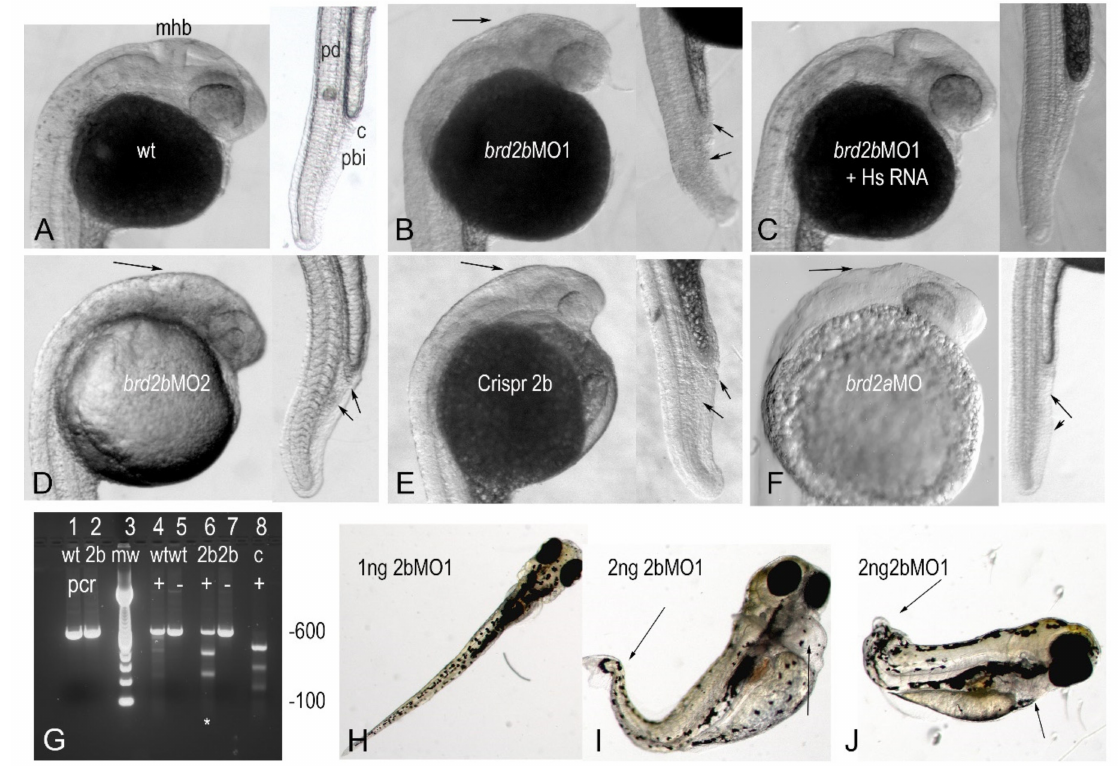
Figure 3. Brd2b knockdown results in reduced hindbrain, ill-defined MHB region, and trunk abnormalities similar to Brd2a morphants, but presents unique circulatory and pronephric defects. Brightfield images of 24 hpf prim 5 embryos ( A – F ), and larvae at 6 days ( H – J ). Lateral views of head and trunk of representative embryos from indicated treatment groups: ( A ) uninjected; ( B ) brd2b MO1-injected; ( C ) Brd2 bMO1 + HsBrd2 RNA co-injected; ( D ) Brd2 MO2-injected; ( E ) Crispr-Cas9- brd2b -disrupted; and for comparison, ( F ) paralog brd2a MO-injected. In A) mhb = midbrain-hindbrain; pd = pronephric duct; c = cloaca; pbi = peripheral blood island. Head and trunk defects in morphants and Crispr-Cas9-treated embryos are indicated by black arrows, and include reduced brain and ill-defined MHB region, misformed pronephric duct, and disorganized PBI. These defects are substantially rescued by co-injection of human Brd2 RNA, recapitulated by a non- overlapping anti- brd2b morpholino (MO2), and phenocopied by Crispr-Cas9 disruption, showing gene-specificity of observed effects. ( G ) Crispr-Cas9 brd2b target validation, showing intact PCR products from wildtype (lane 1, wt) and Crispr-disrupted (lane 2, 2b) brd2b locus; wildtype PCR product treated with mismatch-detecting resolvase (lane 4, wt+) and untreated (lane5, wt − ); Crispr-disrupted PCR product treated with resolvase (lane 6, 2b+) and untreated (lane 7, 2b − ). Crispr-disrupted brd2b locus treated with resolvase shows cleavage products (asterisk highlighting lane 6), while wildtype locus remains intact, indicating that Crispr-Cas9 targeted designated sequences in the brd2b locus. Pixel density of the 600 bp intact product band is reduced from 980 in untreated (lane 7) to 528 in treated (lane 6) Crispr-disrupted embryos, indicating close to 50% efficacy (see Methods). ( H ) Six day old morphant larvae injected at 2 cell stage with 1 ng brd2b MO1, or ( I , J ) 2ng brd2b MO1, illustrating dosage-dependent severe heart edema and trunk deformities, due to nearly complete lack of blood circulation. See Table 1 for population morphology data from these studies. See Supplementary Figure S1 for HsBrd2 RNA control embryos